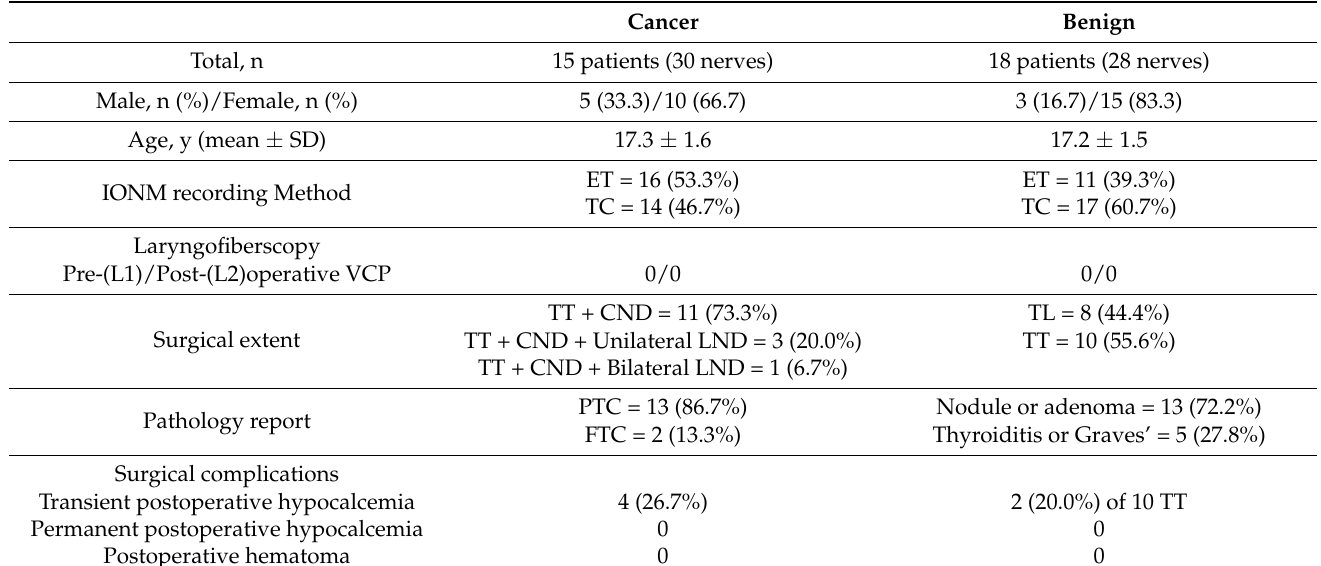
Table 1. Demographic and clinical characteristics of pediatric patients received monitored thyroidectomy. Cancer Benign 15 patients (30 nerves) 18 patients (28 nerves) 5 (33.3)/10 (66.7) 3 (16.7)/15